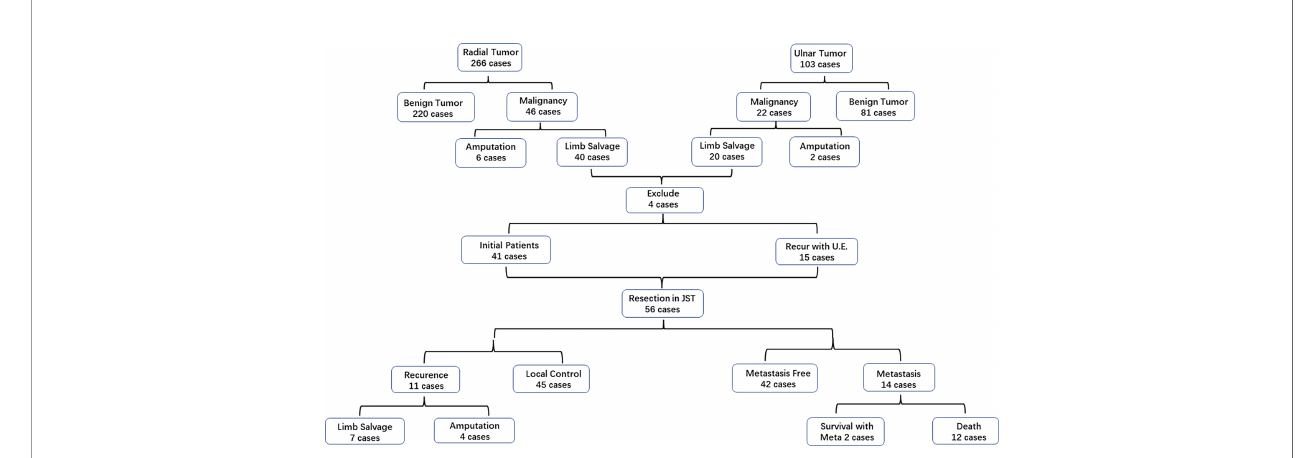
FIGURE 1 | Overview of case enrollment and treatment process in